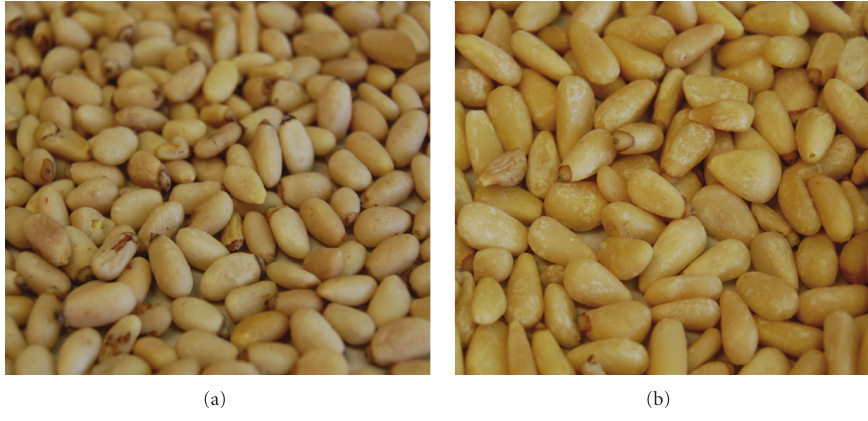
Figure 1: Pinus armandii (a) and P. koraiensis (b) pine